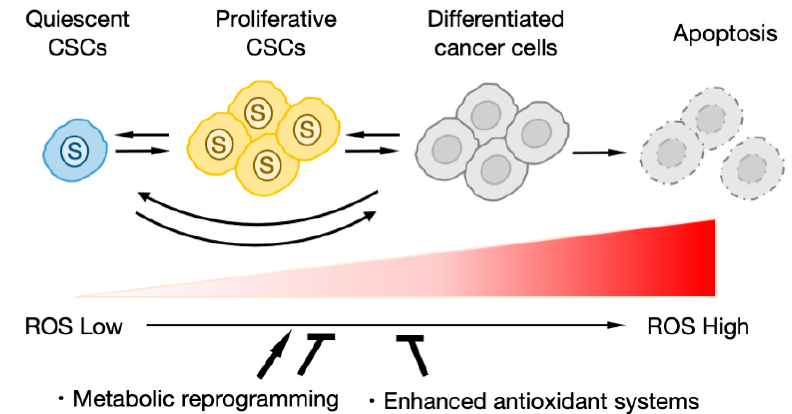
Figure 3. The redox regulation and differentiation of CSCs. Quiescent CSCs maintain low-level reactive oxygen species (ROS) by glycolysis-dependent metabolism or enhanced antioxidant systems. ROS accumulation associated with OXPHOS activation induces CSC proliferation and differentiation.